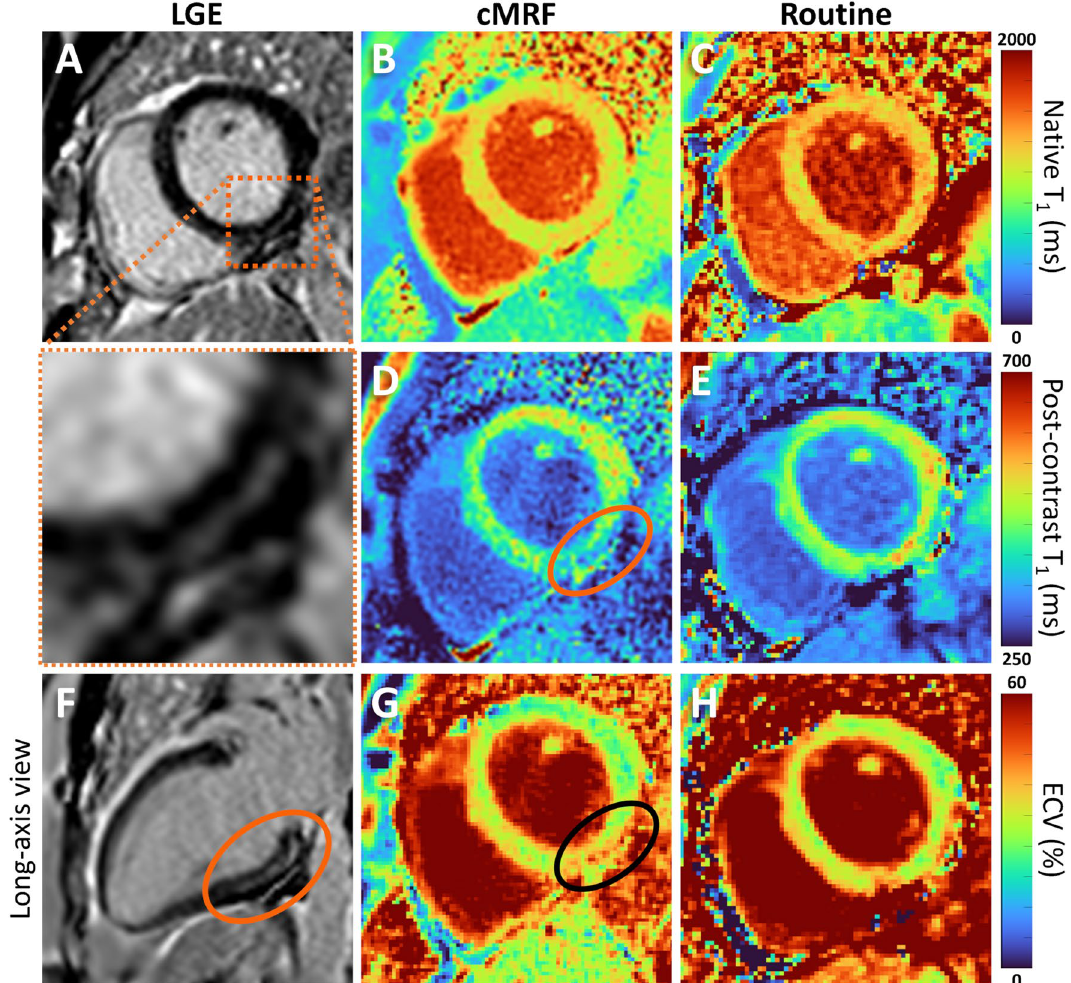
Figure 3. T 1 and T 2 maps in a 40 y.o. patient with viral myocarditis and old sub-epicardial scar in the basal infero-lateral and inferior wall. ( A , F ) Short- and long-axis late-gadolinium-enhanced (LGE) images showing the presence of the subtle subepicardial scar. ( B , C ) Native T 1 maps. The routine T 1 map had slightly higher overall T 1 myocardial values. ( D , E ) T 1 maps 20–25 min after contrast agent injection. We can observe that the small non-transmural subepicardial lesion is easier to identify in the cMRF scan. ( G , H ) ECV maps obtained with cMRF and routine technique. The sub-epicardial scar is visible in the cMRF ECV